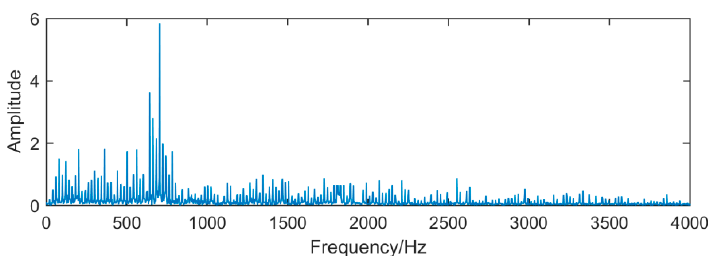
Sensors 2018 , 18 , x FOR PEER REVIEW Figure 14. Time domain waveform of the fault signal. Figure 14. Time domain waveform of the fault signal. Figure 14. Time domain waveform of the fault signal.